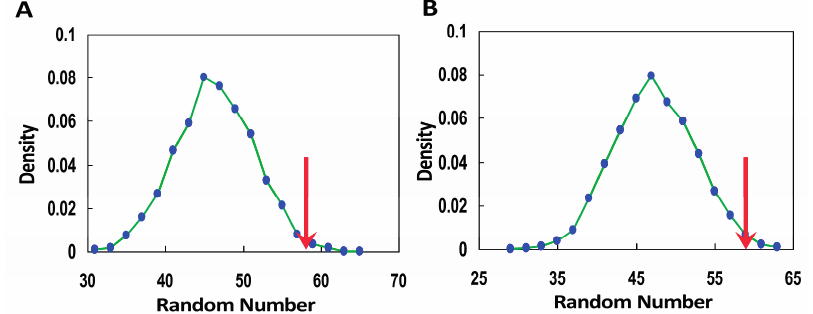
Figure 2. Evidence for the model from large-scale analysis of SNPs under positive selection ( A ) and SNPs associated with disease from GWAS ( B ). The green curves represent the distributions of random number of synonymous SNPs changing miRNA regulation under recent positive selection ( A ) and those associated with disease ( B ). The red arrows represent the real number of synonymous SNPs changing miRNA regulation in cases of A and B,